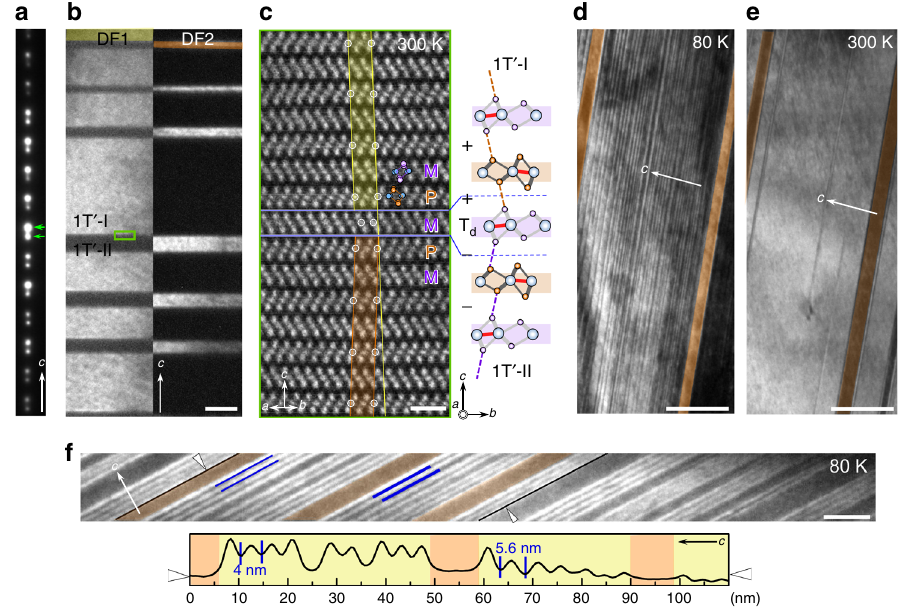
Fig. 2 Phase domain walls along cross-section views at room and cryogenic temperatures. a A selected area electron diffraction (SAED) pattern of 1T´ monoclinic twins, revealing spot splitting along the c axis. b DF-images were taken using the strong and weak (1 (cid:1) 12) spots (green arrows) of variants 1T´-I and 1T´-II, denoted as DF1 and DF2, respectively. Yellow and orange false colors are added to aid the eye. The average twin width is on the order of a half- μ m, and the two types of twin domains are typically unequal in size. Scale bar: 200 nm. c The atomic-resolved HAADF-STEM image over one twin wall along the [110] zone axis. Overlaid color-coded 1T´ unit cells de fi ned by white-circled Mo atomic columns show a glide-re fl ection twin. The twin is composed of one M layer (marked by blue dashed lines) with anti-phase ( + / − ) interlayer shearing, connecting 1T´-I (yellow-shaded) and 1T´-II (orange- shaded) regions. The lattice model viewed along [100] is shown for clarity. Scale bar: 1 nm. d , e DF-images taken at ( d ) 80 K and ( e ) 300 K. At 80 K, the phase-separated state is observed. The appearance of thin T d layers within the initial 1T´ twins, revealing additional ( (cid:1) 112) spots due to an orthogonal T d unit cell as shown in Fig. 3a. Scale bar: 200 nm. f A higher-magni fi cation DF-image, showing superlattice-like − (T d ) m (1T´) n − ( m , n = integer) nanoscale phase DWs at 80 K and the corresponding intensity pro fi le between white arrow heads along the c direction, covering both 1T´-I (yellow) and 1T´-II (orange) twins. The image is rotated and enlarged to enhance the display. Scale bar: 30 the diffraction spots (Fig. 2a) resulting from adjacent twin can be readily identi fi ed by tracking the white-circled Mo domains. 1T´ twinning occurs by a mirror operation along the ab - positions. The yellow and orange shaded areas outline the 1T´ plane. A further zoomed-in HAADF-STEM image of a twin wall monoclinic unit cells above and below the interfaces. It turns out (Fig. 2c) shows an atomically coherent interface between 1T´-I that in addition to a mirror operation, a gliding of atomic layers is and 1T´-II along [110]. The interfaces (the blue lines in Fig. 2c) imposed on either side of the twin wall to reduce lattice strain. As